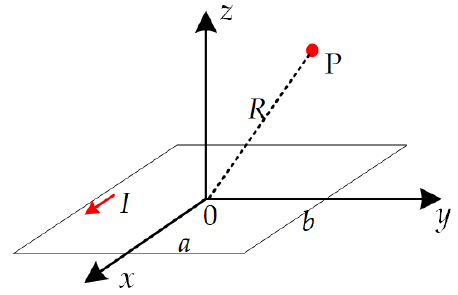
Figure 9. Rectangular Loop Antenna with Current I .